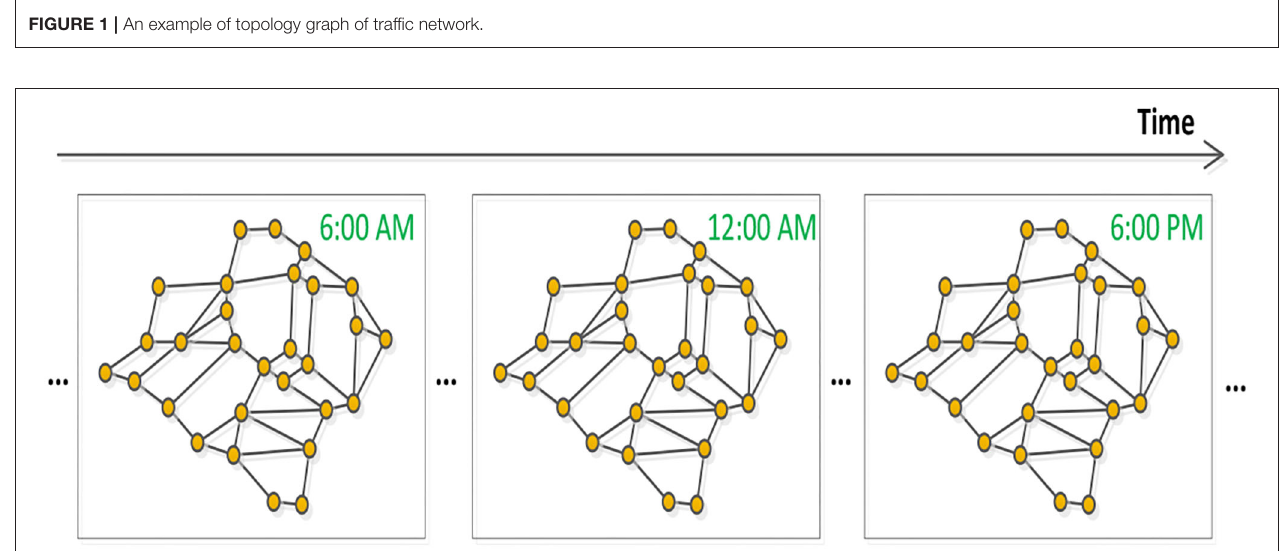
FIGURE 2 | Traffic temporal-spatial graph